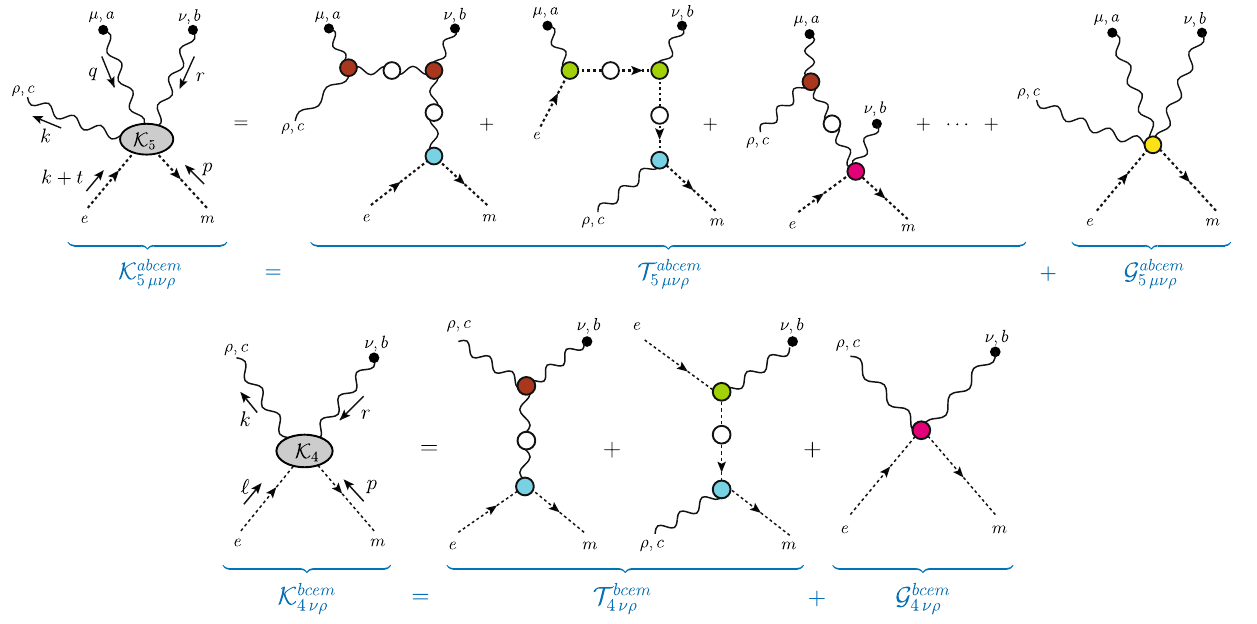
Fig. 3 Diagrammatic representation of the SDE for the BB ¯ cc. The gray ellipses represent the five- and four-points kernels, K abcem respectively. The diagram obtained from ( b ) through crossing of the gluon legs, μ, a ↔ ν, b , is not shown